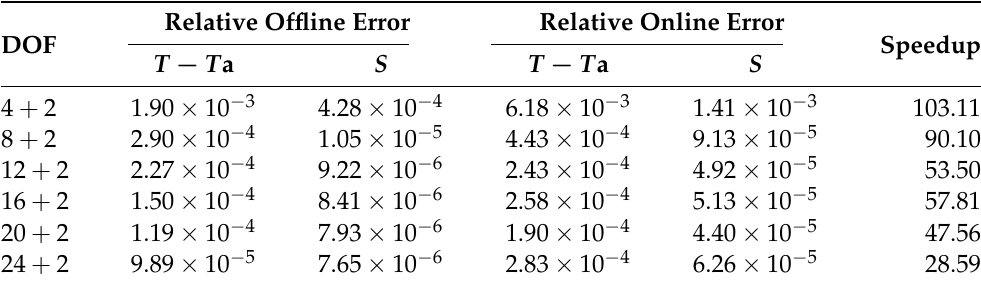
Table 3. Comparison of the relative offline and online errors for the sPOD-sDEIM ROM, trained and tested with β = 558.49 K, for different numbers of modes.